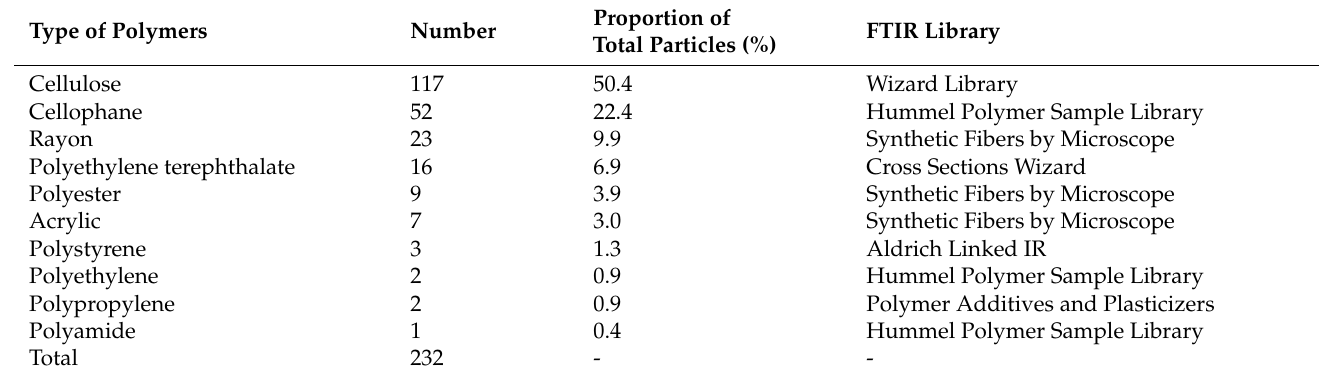
Table 2. Information on the identified